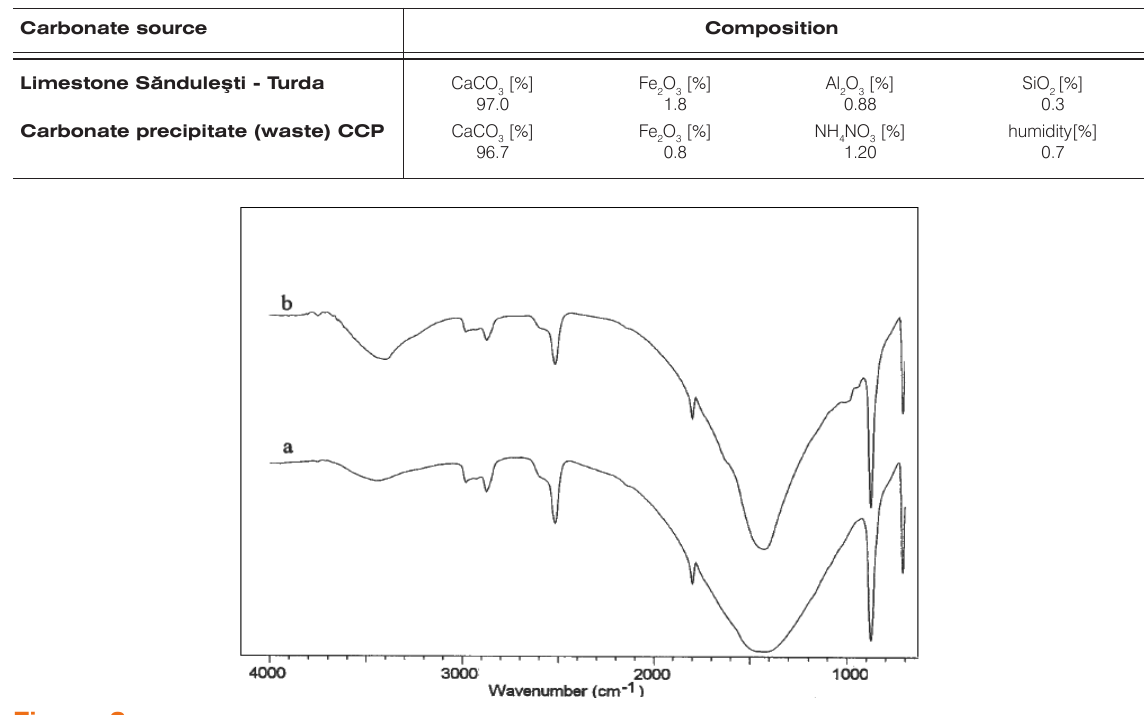
Figure 2. IR spectra of calcium carbonate. a.) - calcium carbonate precipitate (waste) of NP fertilizer industry; b) – natural limestone from Sănduleşti-Turda.